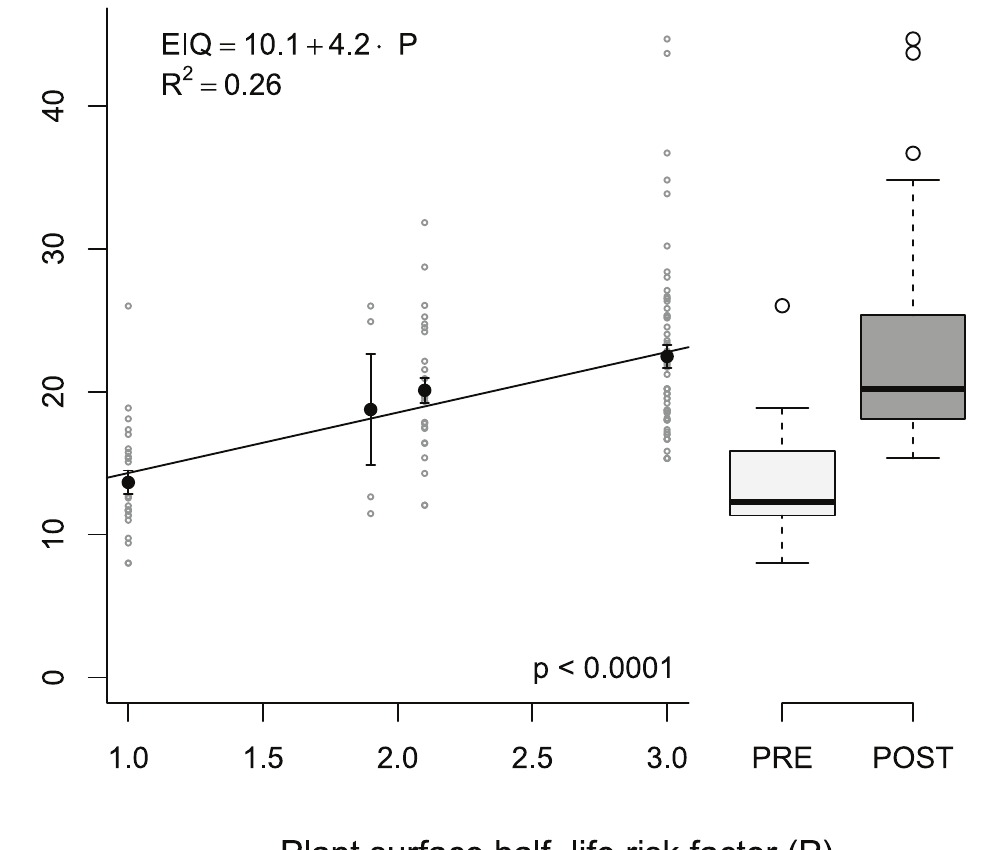
Fig 4. The relationship between plant surface half-life risk factor (P) and EIQ value for 116 herbicides (Senseman data set). Filled circles with error bars represent means and standard errors, grey open circles represent individual herbicides (N = 116). For box-plots, dark bars represent median EIQ value, boxes enclose the first and third quartiles; preemergence (PRE) and postemergence (POST) boxplots represent the data for P = 1 and P = 3,